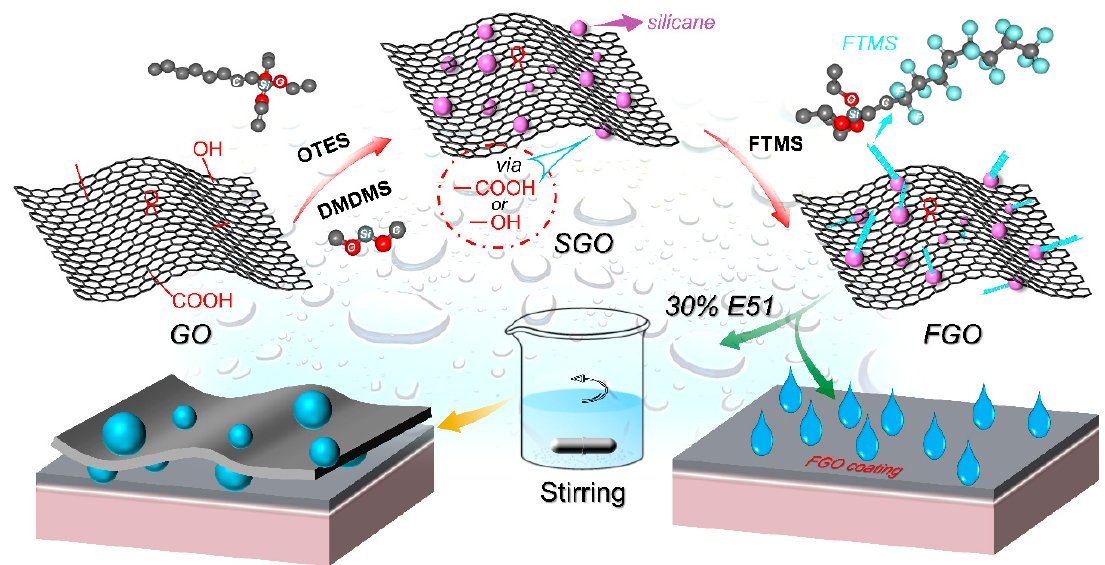
Figure 1. Diagram of preparation of FGO and composite coating E-FGO.